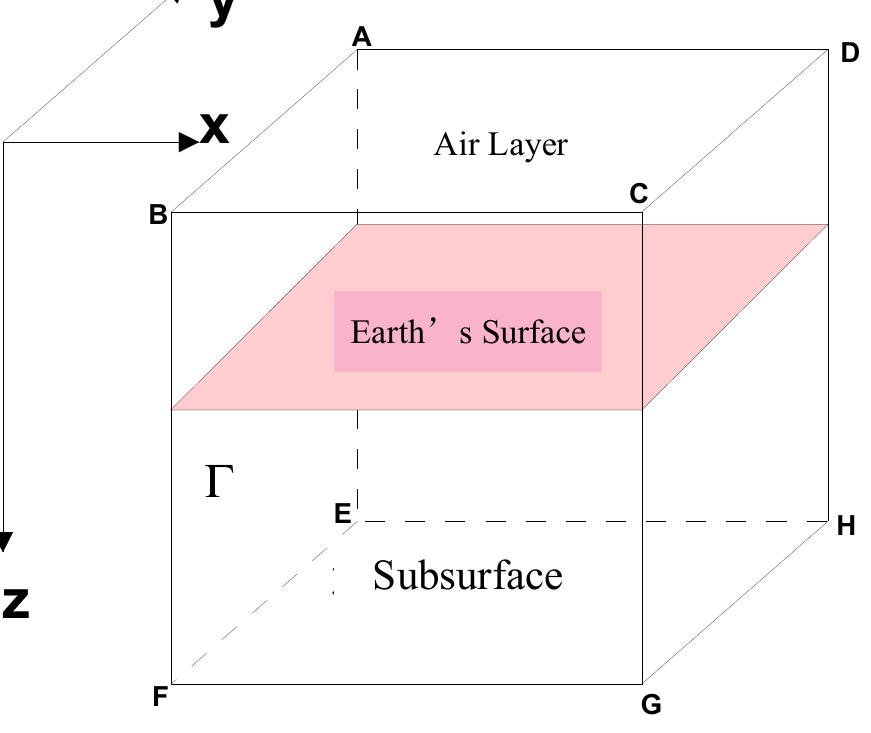
Figure 1. Schematic diagram of the 3-D medium model. An orthogonal component of the initial incident plane wave field is distributed along the x-direction, and 𝐸 of the air layer in the model is set as 1 unit with other components (cid:3051) as 0. As for the last four side boundaries, the direction of the electromagnetic field wave vector is perpendicular to the direction of the boundary normal. The infinitely deep bot-